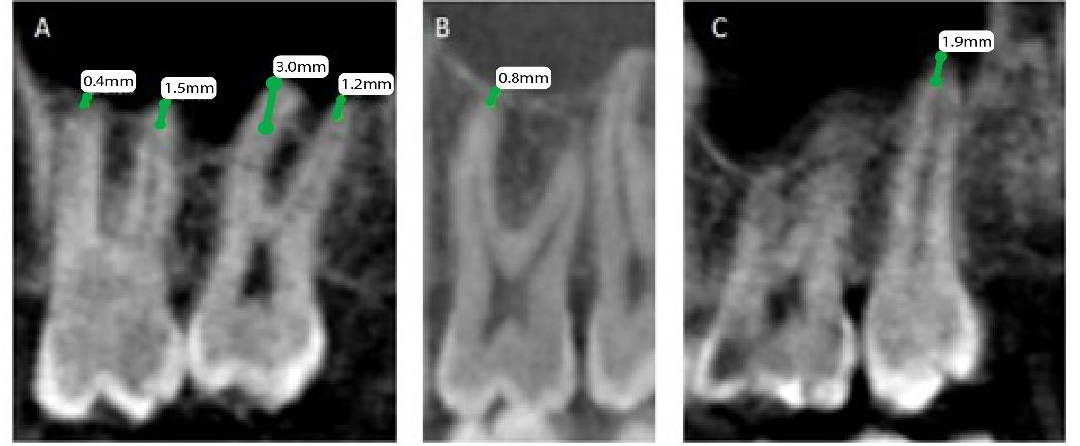
Figure 3. CBCT sagittal view showing the distance between the maxillary sinus and the root of per- manent maxillary. ( A ) Right first and second molars with mesiobuccal and distobuccal roots, ( B ) left first molar mesiobuccal root, and ( C ) left second molar palatal root.